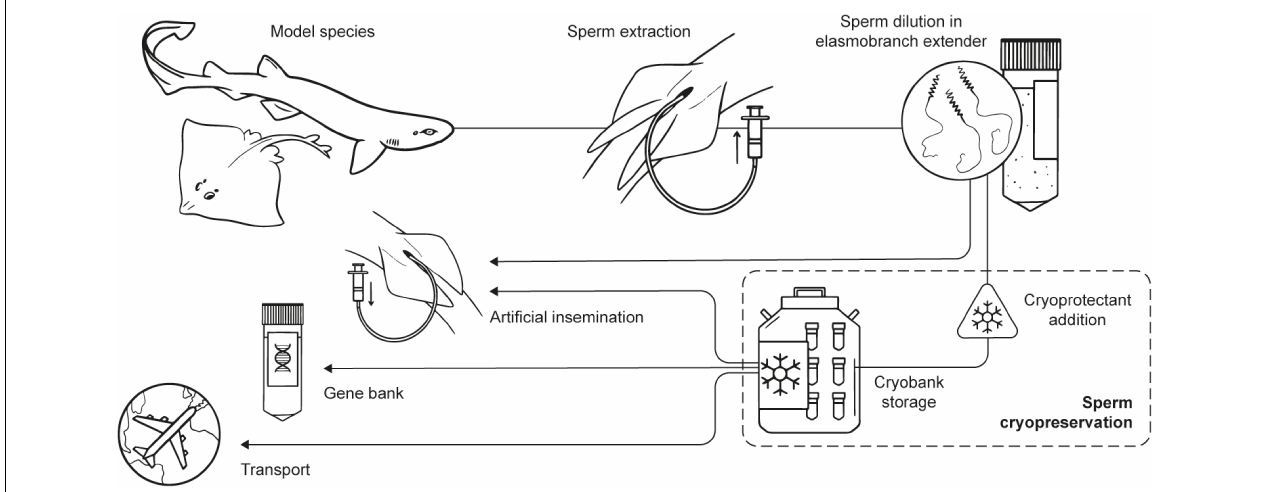
FIGURE 1 | Experimental steps and potential applications. Scheme of the main experimental steps of the process (obtention of the specimens, sperm extraction, sperm dilution, cryopreservation, and storage) and potential uses derived from the outcomes of the study in ex situ conservation programs (sperm worldwide transport, gene bank, artificial